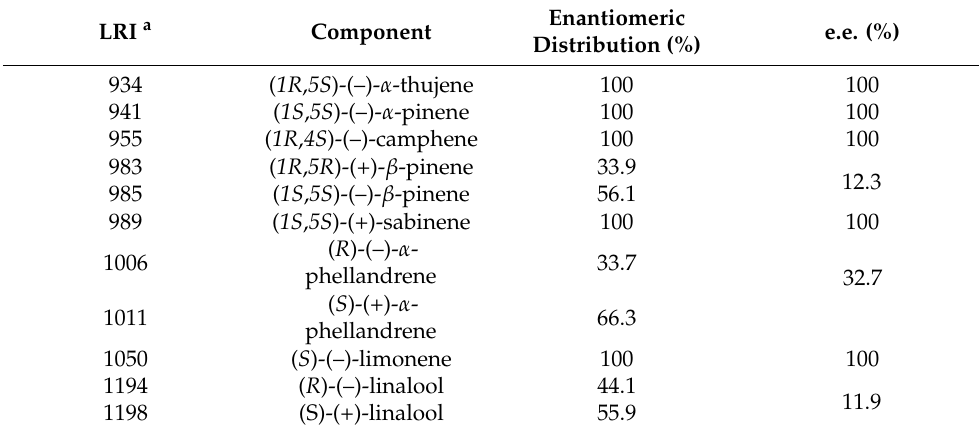
Table 2. Enantiomeric analysis from H. strigosum essential oil.